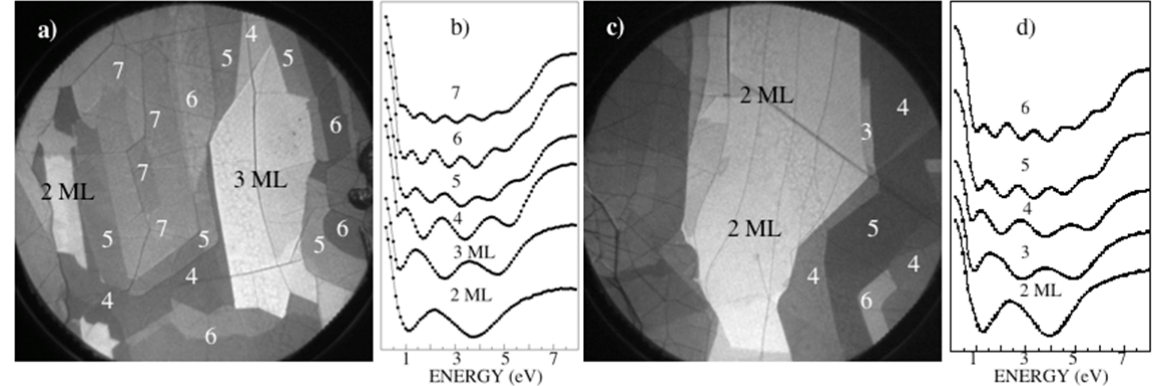
Figure 3. LEEM images collected at a field of view (FOV) of 15 μ m from an in situ C-face sample using an energy of ( a ) 1.8 eV and from another position ( c ) at an energy of 2.0 eV. The electron reflectivity curves in ( b ) and ( d ) extracted from different locations in ( a ) and ( c ) reveal fairly large areas of 3 MLs and 2 MLs of graphene,